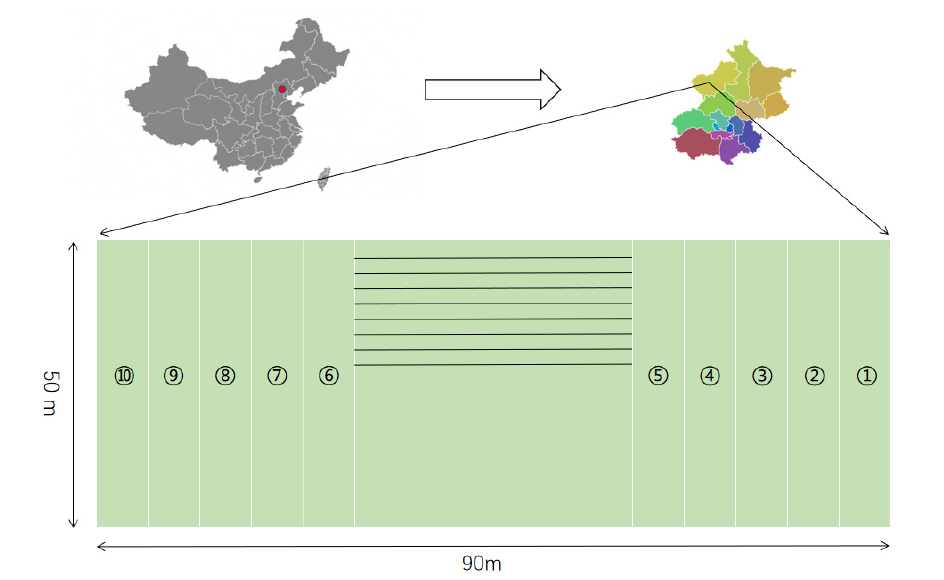
Figure 1. Experimental plots. Note: 1 (cid:13) , Zhongmai 175; 2 (cid:13) , Lunxuan 987; 3 (cid:13) , Shixin 828; 4 (cid:13) , Lunxuan